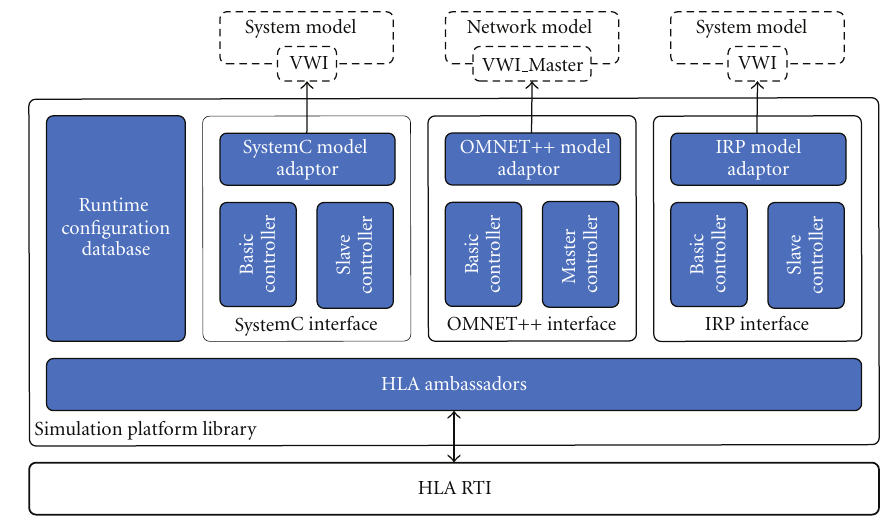
Figure 6: Simulation platform